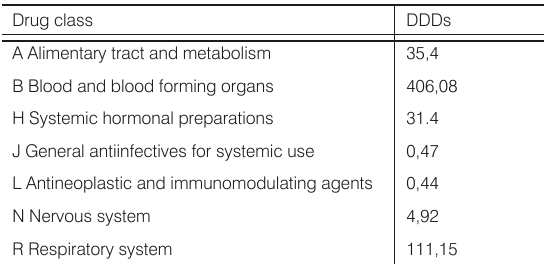
Table 4. Utilization of drug groups (ATC classification) as number of DDDs/100 bed